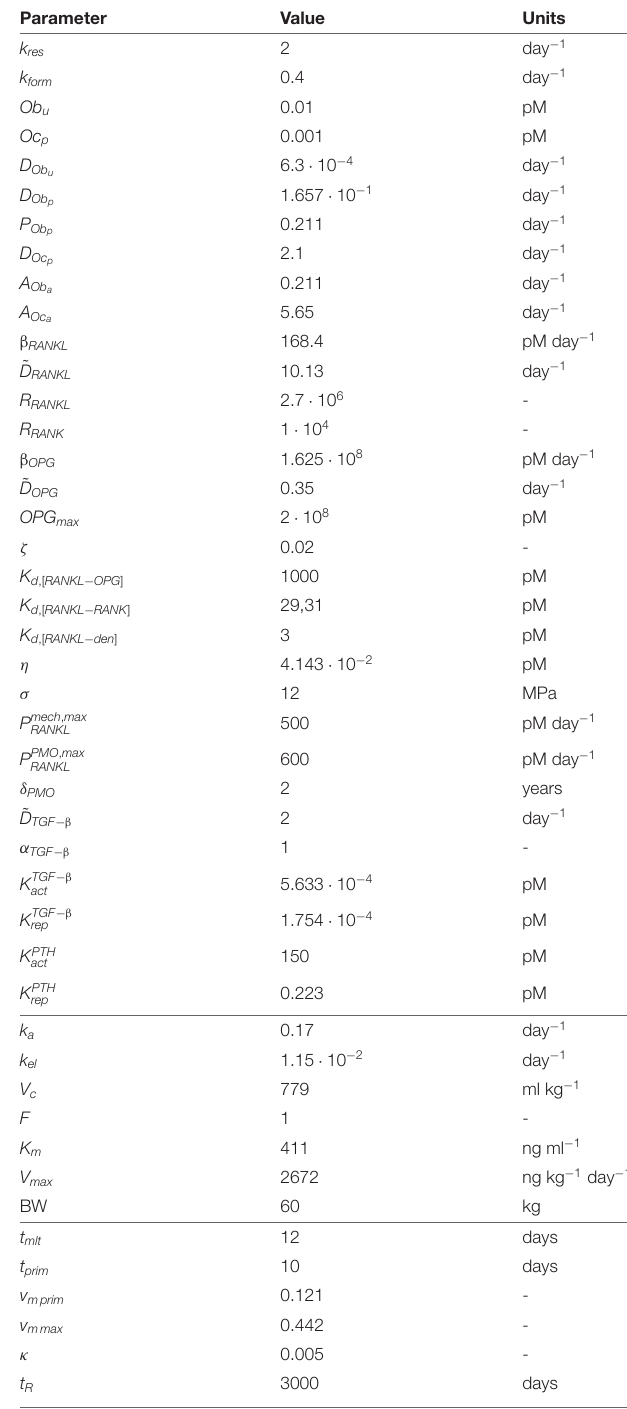
TABLE A1 | Values taken for the constants of the PK-PD